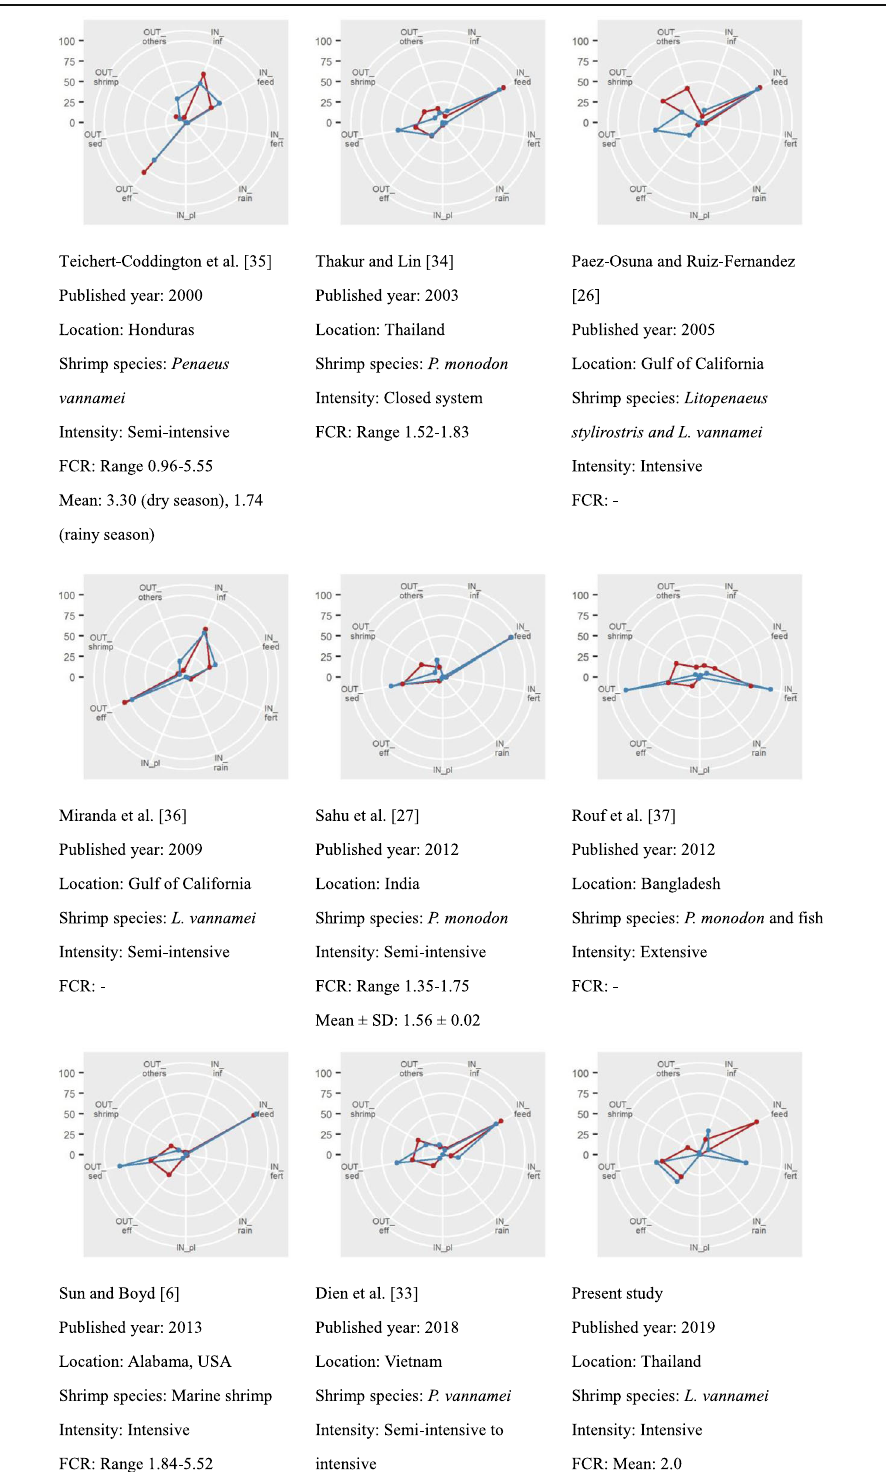
Table 5 Nutrient budget approach and FCR analysis of shrimp farming from a range of settings and scales expressed by radar chart. A scale in percentage displays N mass (in red) and P mass (in blue) generated by different